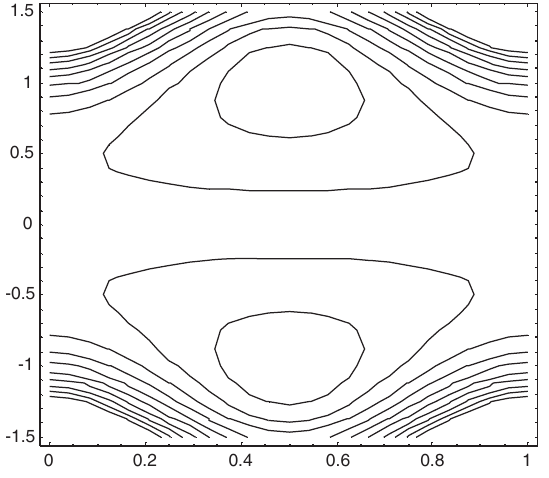
Fig. 15. Streamlines in the wave frame when Q =0.9, φ =0.6, M =0.01, N =0.25.